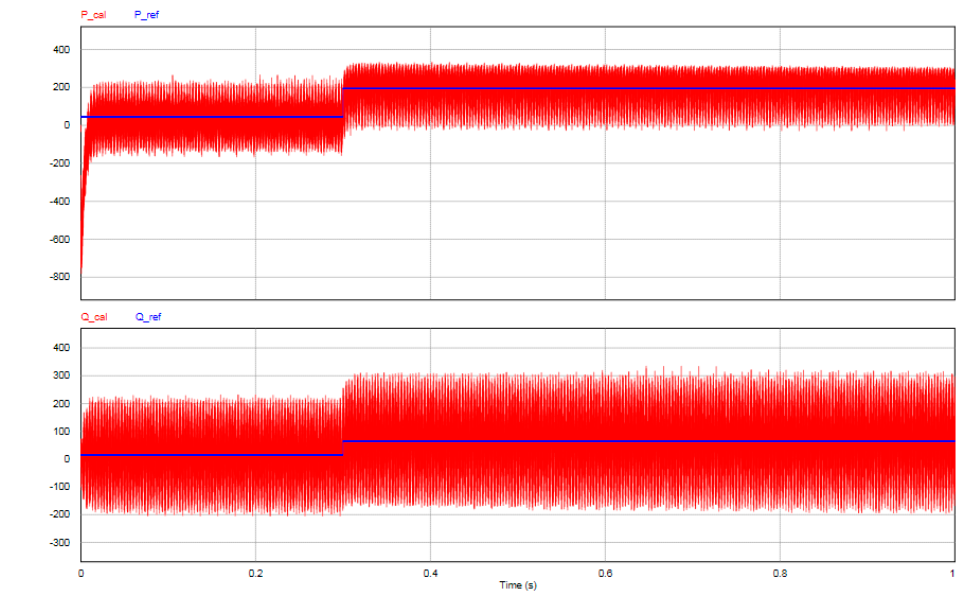
Figure 21. Active and reactive power (reference vs. calculated).